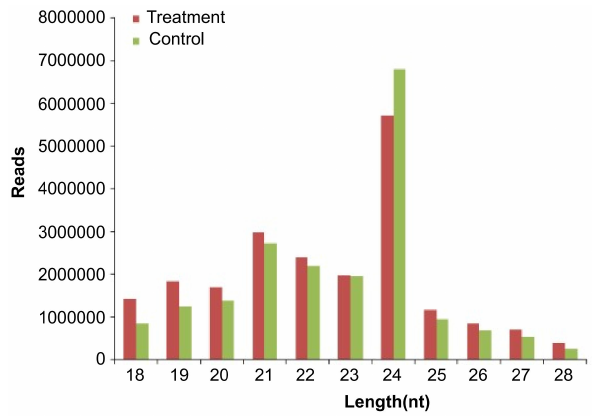
Figure 1. Read length distribution of small RNAs.